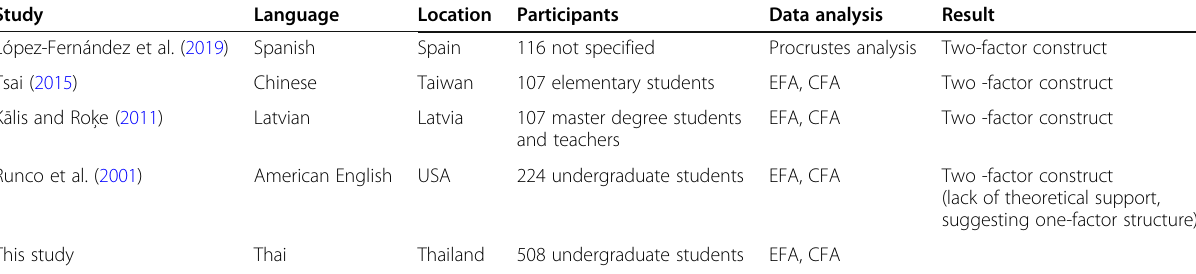
Table 1 Studies related to RIBS psychometric assessment in different